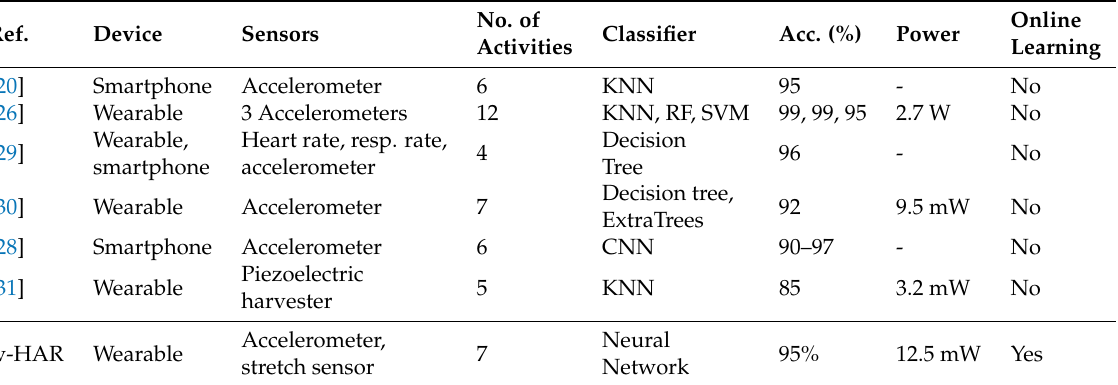
Table 1. Summary of HAR